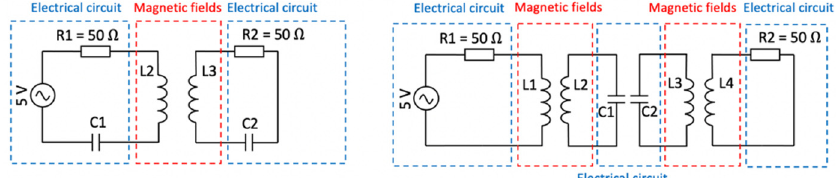
Figure 2. The schematics of two-coil ( left ) and four-coil ( right ) MR-WPT systems in COMSOL.